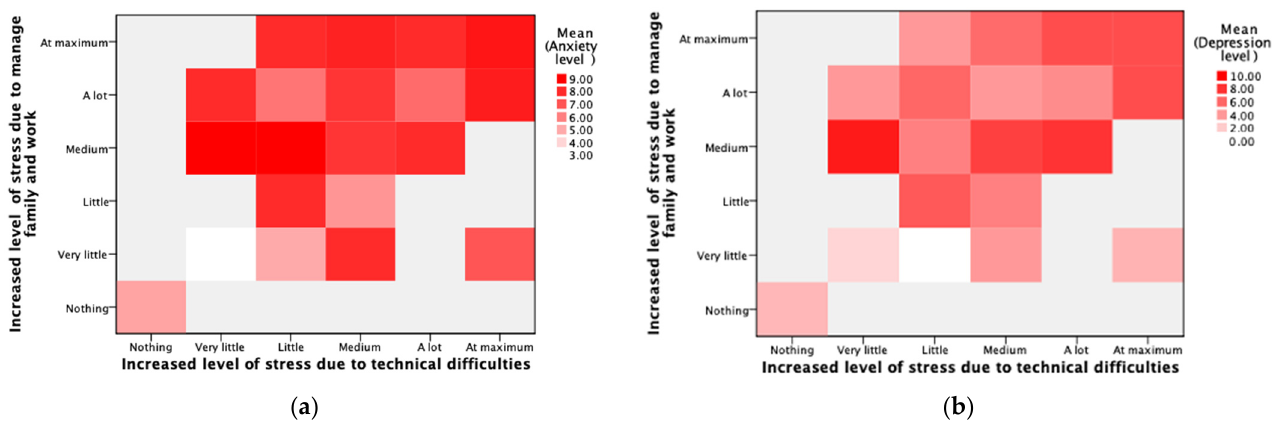
Figure 2. Comparison of the correlations between the technical issues and the balance between the family and work related to the anxiety ( a ) and depression levels ( b ) through a heat map.